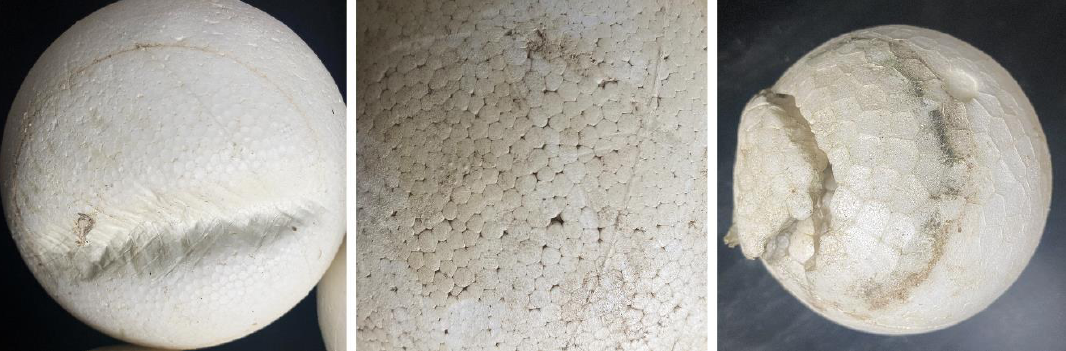
Figure 12. Common failure modes of EPS balls.